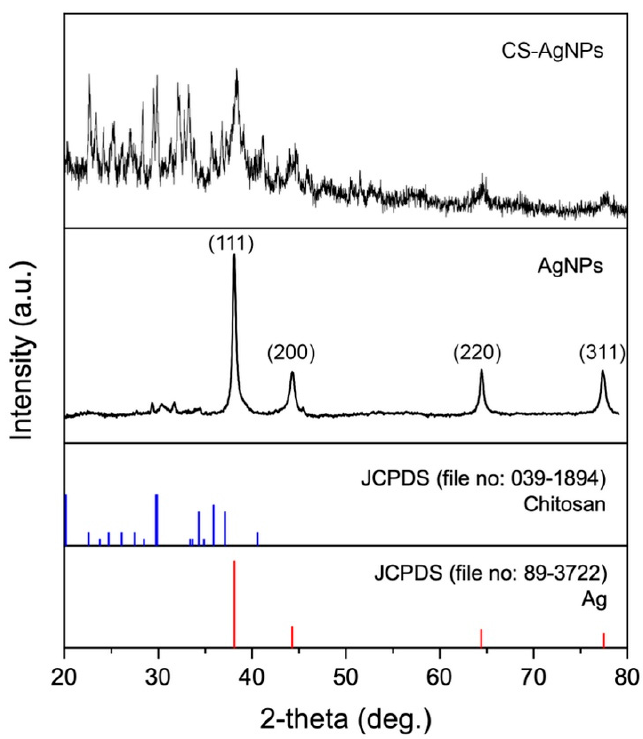
Figure 4. XRD patterns of CS-Ag NPs and Ag NPs synthesized using chitosan-immobilized biomass and an aqueous extract of unencapsulated fungal biomass of S. hirsutum .